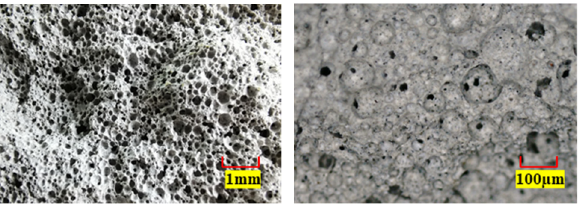
Figure 1. Microporous morphology of foamed concrete.